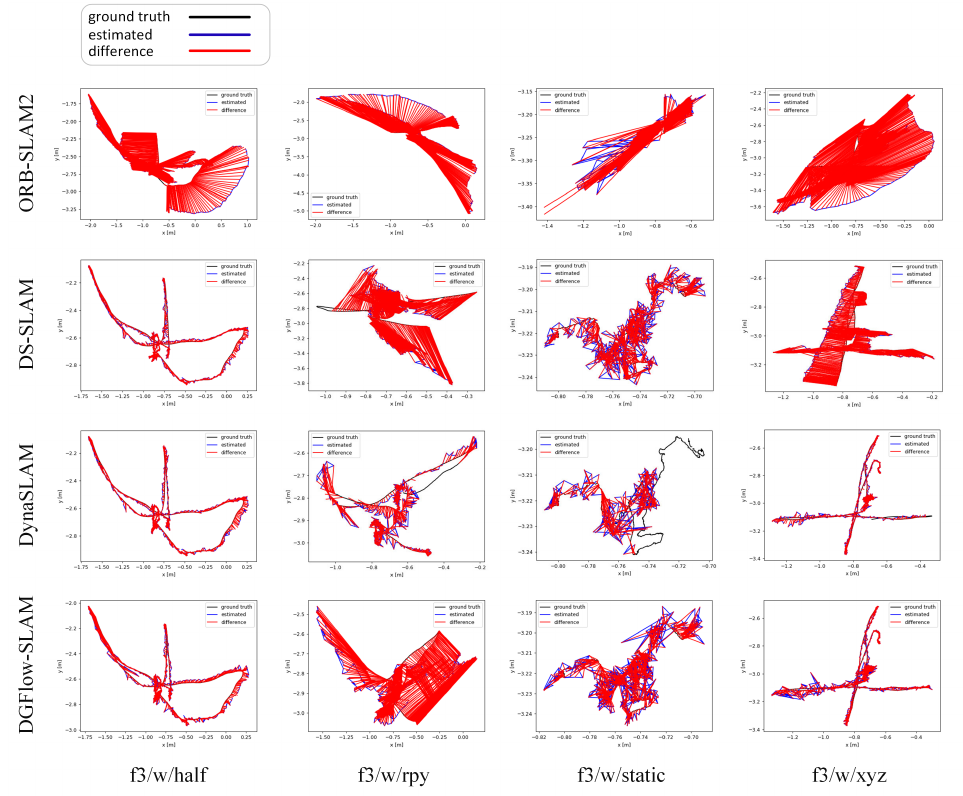
Figure 4. This is the camera trajectory image. Black lines are the true trajectory and blue lines are our estimated camera trajectory. Except for w/rpy, on the other three datasets, our estimated trajectory is basically around the real